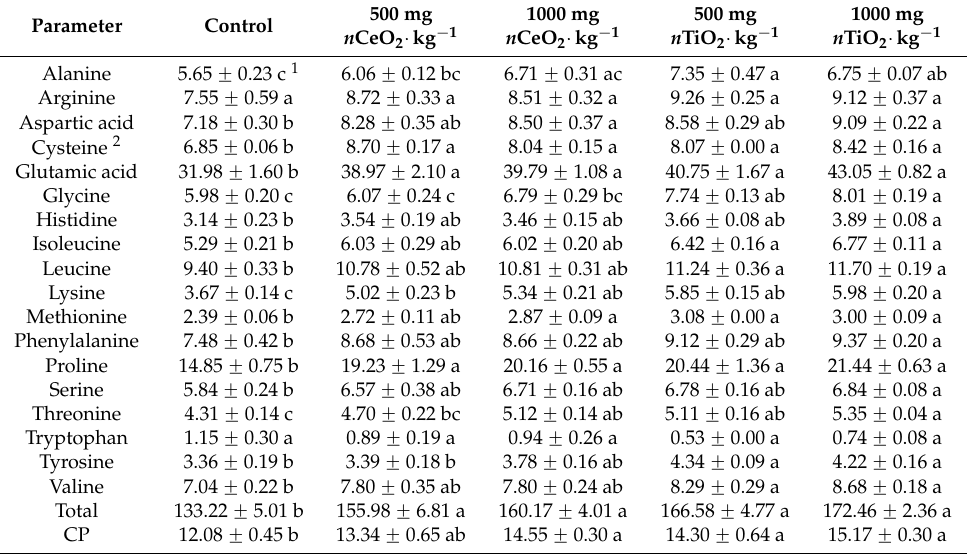
Table 4. Amino acid (mg ¨ g ´ 1 ) and crude protein (CP, %) concentration in barley kernels at ripening from main shoot grown in soil treated with none (Control), 500 mg n CeO 2 ¨ kg ´ 1 , 1000 mg n CeO 2 ¨ kg ´ 1 ,